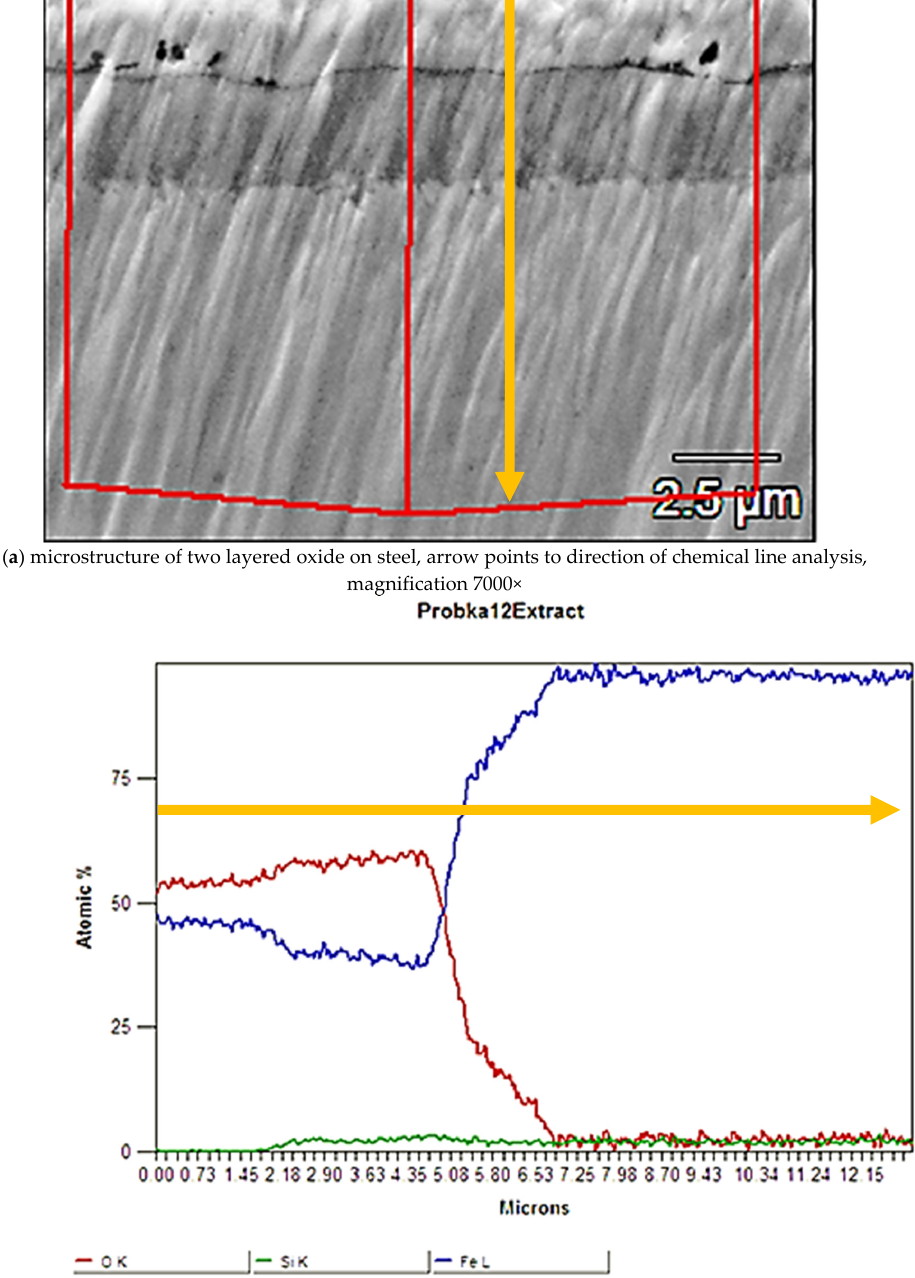
Figure 8. Linear analysis of the chemical composition of the oxide layer, sample v7 (22 h annealing). ( a ) microstructure of two layered oxide on steel, the red lines and arrow points to the scope of the chemical composition test, magnification 7000 × ; ( b ) distribution of content of Fe, O and Si in the oxide layer, blue line—Fe, red line—O and green line—Si; the direction of arrow from left to right corresponds to the direction from the surface into the specimen; oxygen disappears after about 7 µ m from surface, the green Si line in the area where oxygen is present indicates its presence in the oxide